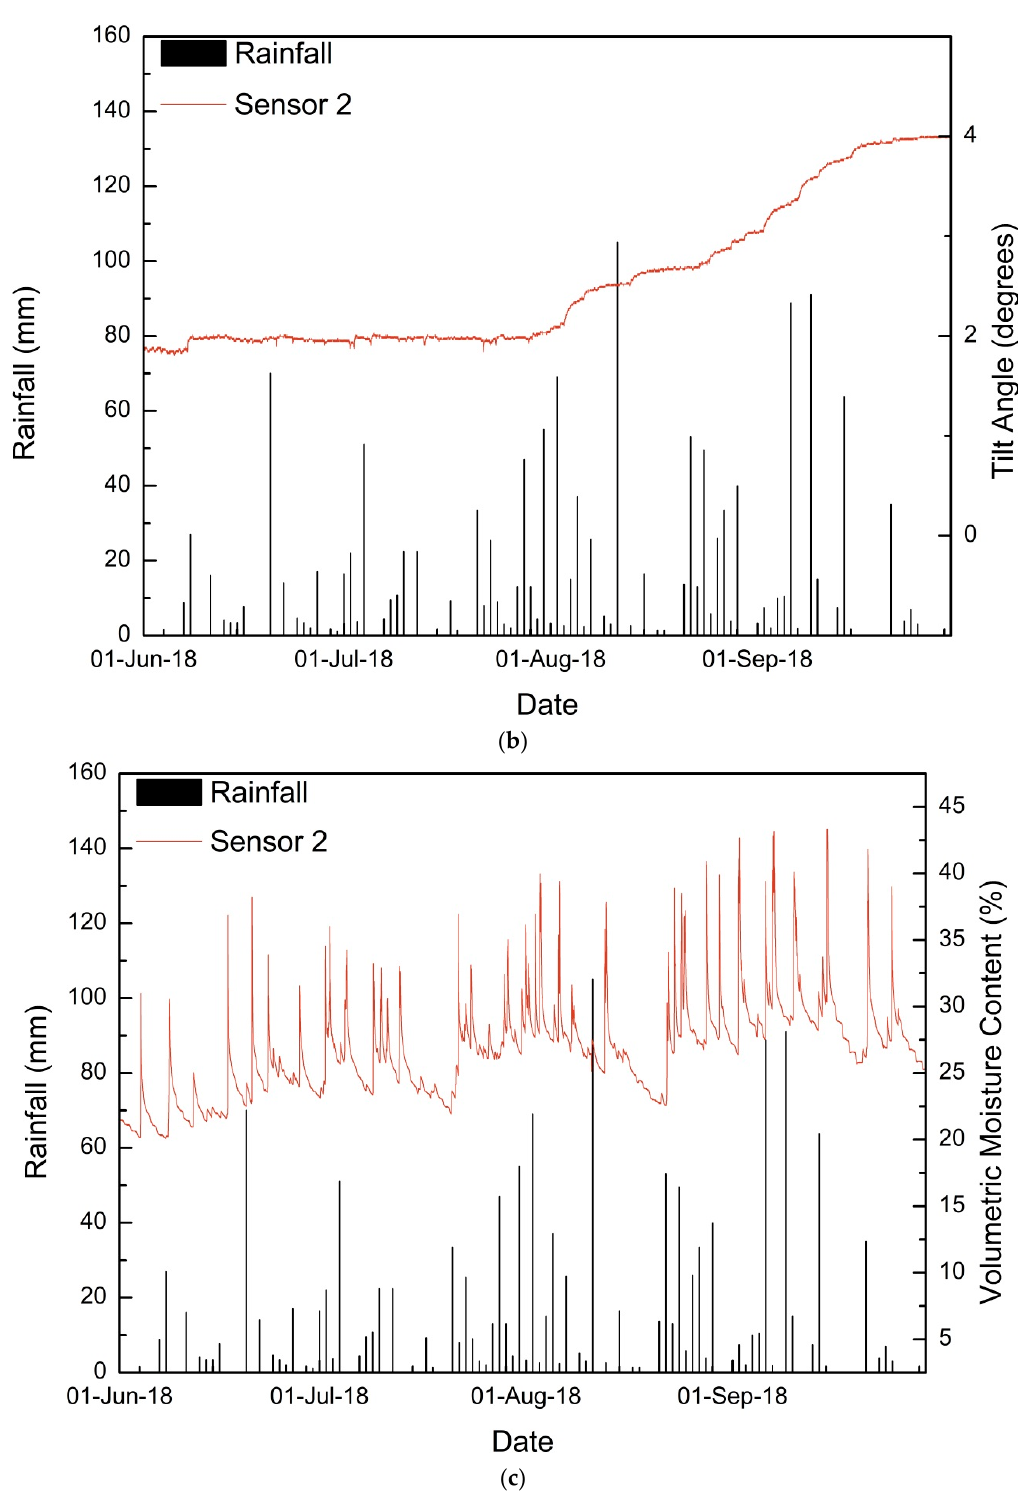
Figure 10. Detailed time history for monsoon 2018 of sensor 2: ( a ) tilting angle in the direction parallel to the slope, ( b ) tilting angle in the direction perpendicular to the slope, and ( c ) volumetric moisture content.